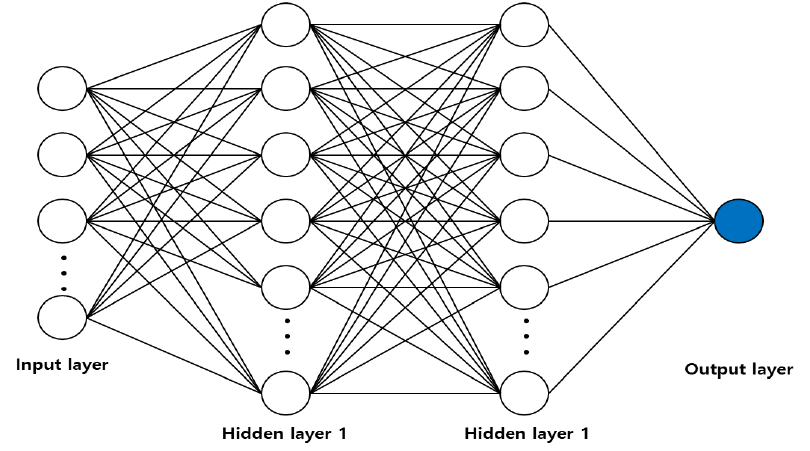
Figure 3. Model configuration of MNN.